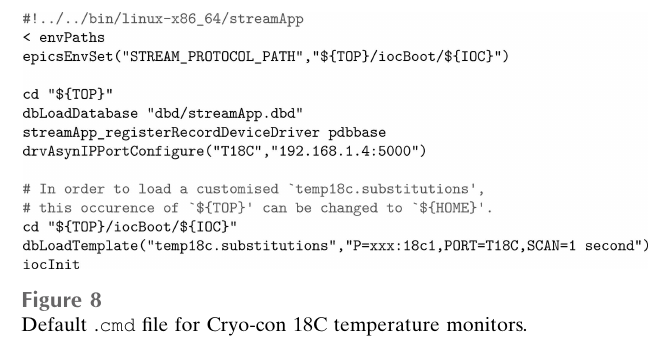
Figure 8 Default : cmd file for Cryo-con 18C temperature monitors.